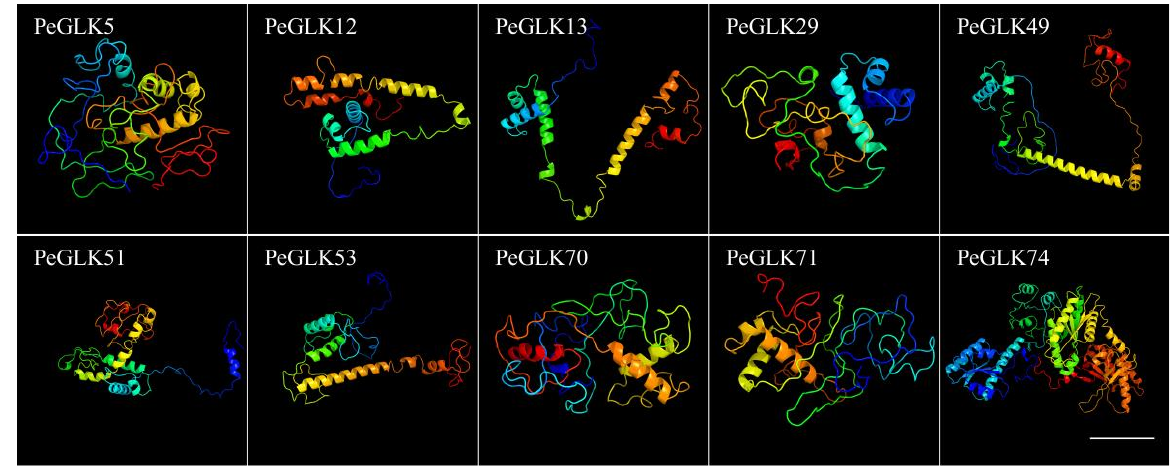
Figure 5. Predicted structures of PeGLK proteins. Structures of 10 PeGLK proteins were predicted with >98% confidence. All colored lines represent α‐ helix, and the arrow with plane shape is β‐ sheet, which displayed only in PeGLK74. Bars: 20 nm.